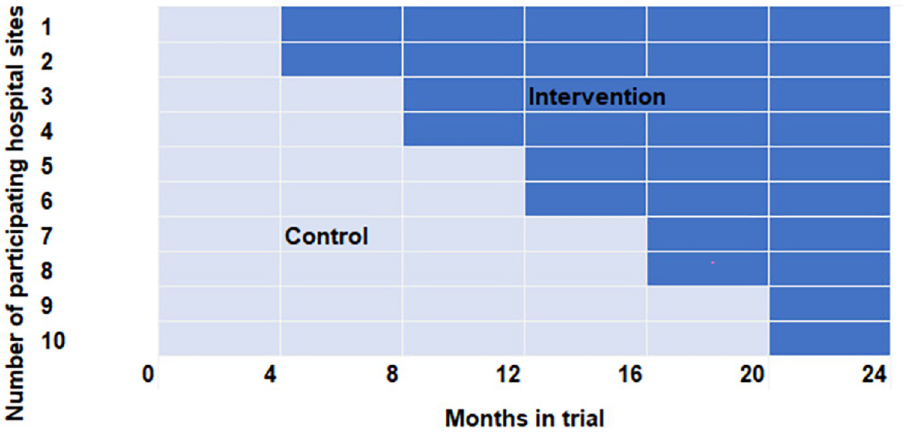
Fig 2. Stepped wedge trial